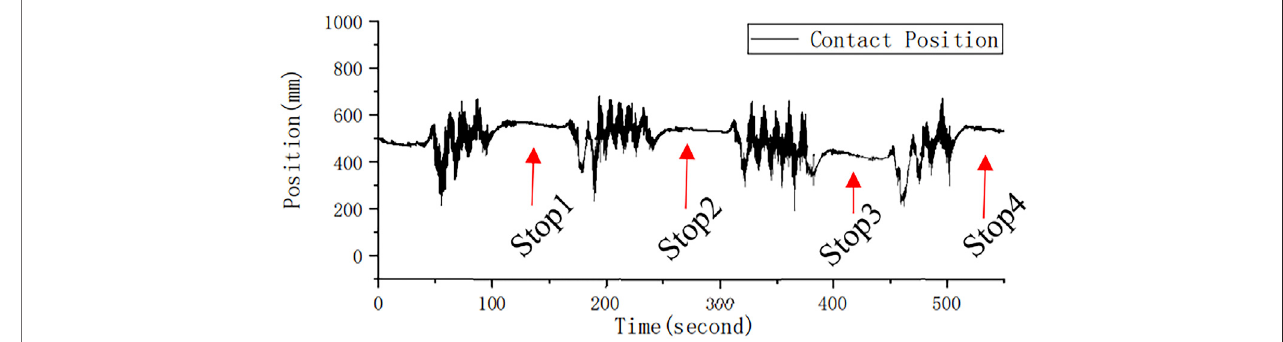
FIGURE 11 | Contact force position varying with a “ Z ” shape manner.